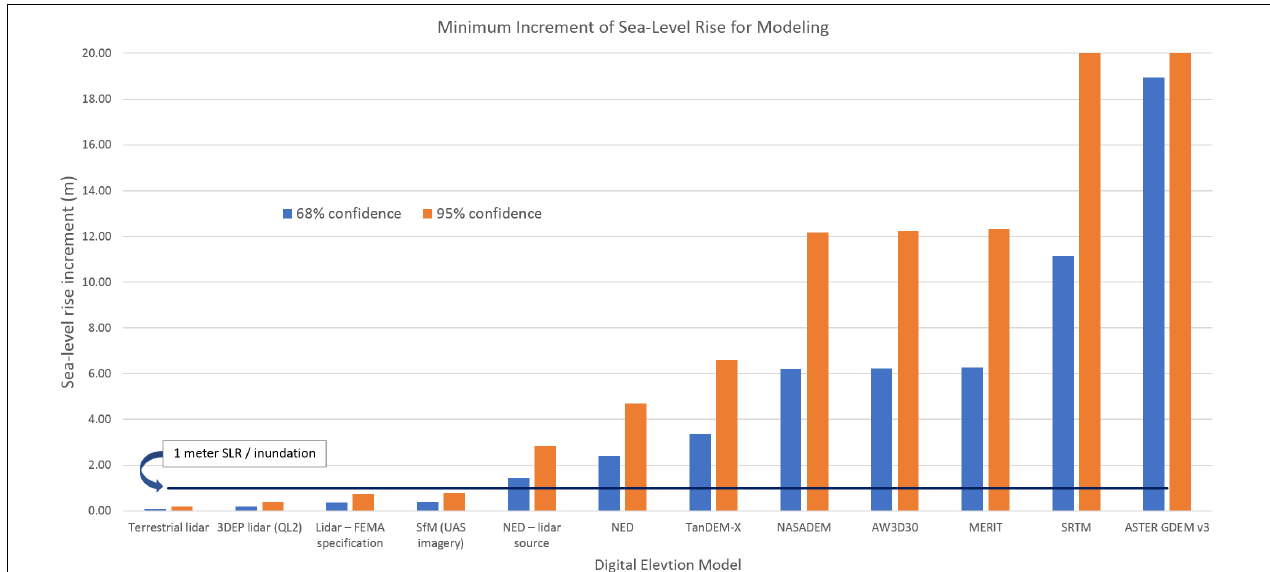
FIGURE 2 | Ranking of elevation data sources (left to right in order of increasing SLRI min ). The 1-m sea-level rise (or inundation level) is marked, which indicates that only the high-accuracy DEM sources are suitable for modeling sub-meter increments at high confidence levels.